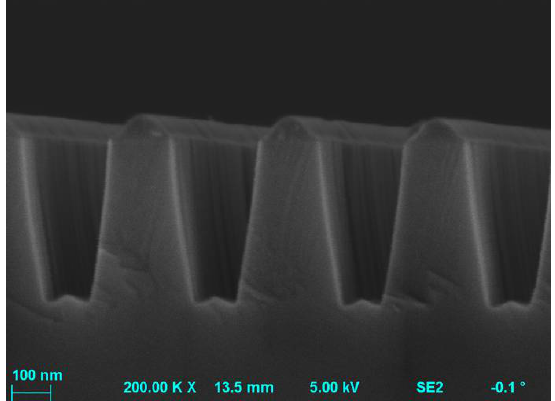
Figure 3. SEM image of etching into SiC—it is visible the trench structure with a period of 360 nm and the etching depth of 430 nm, and the shape determined by a perpendicular incident beam of reactive ions and radicals. The etching process parameters were: O 2 flow rate = 2 sccm, SF 6 flow rate = 20 sccm, P RIE = 100 W, P ICP = 1300 W, p = 10 mTorr, t = 10 min.